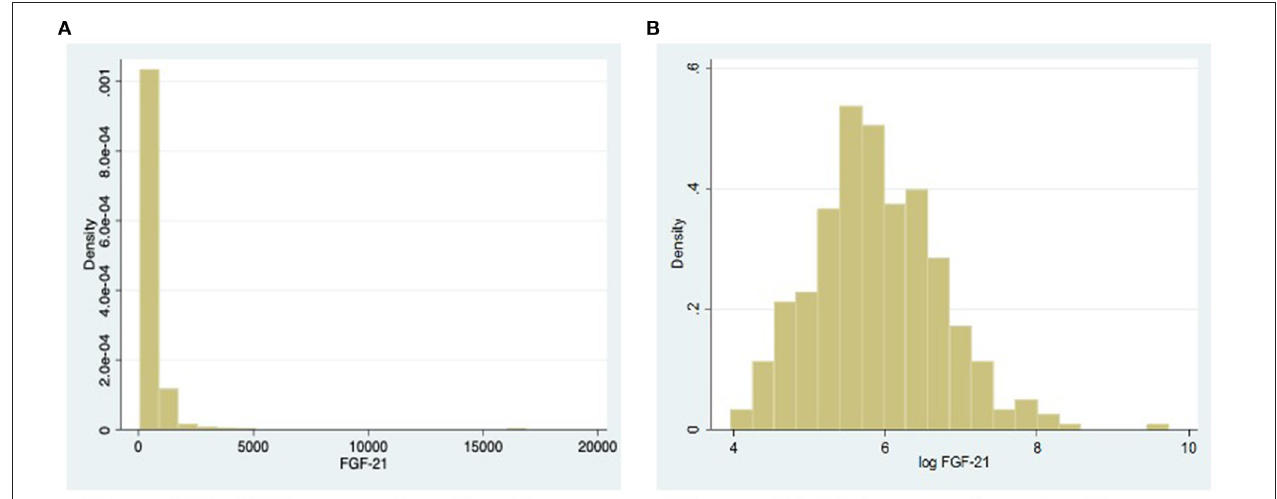
FIGURE 1 | (A) Histogram showing the distribution of fibroblast growth factor 21 (FGF21). (B) Histogram showing the distribution of FGF21 after natural log